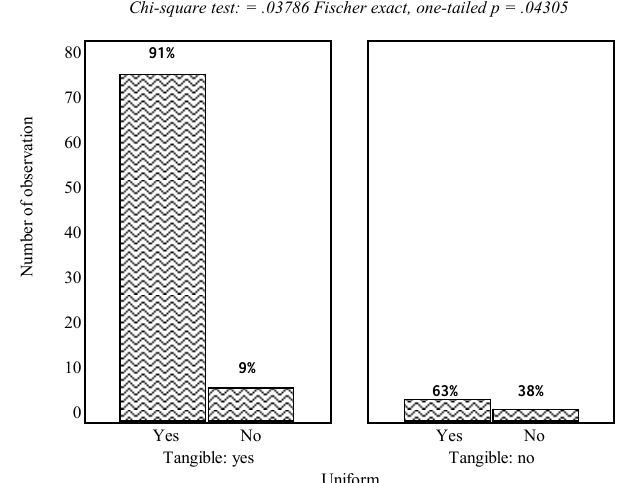
Figure 4: Product characteristic tangibility/intangibility and uniform/non-uniform brand transmutation